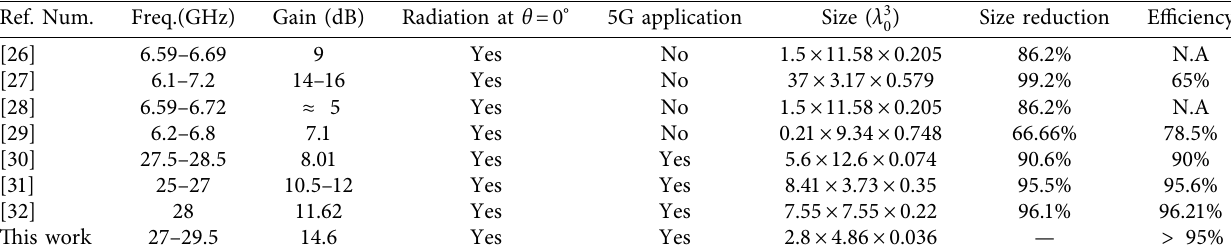
paths. In Figure 12 when the green diodes are on “on” state and blue diodes are “of,” θ � − 11 ° and When the green diodes are on “of” state and blue diodes are “on,” θ � 11 ° .